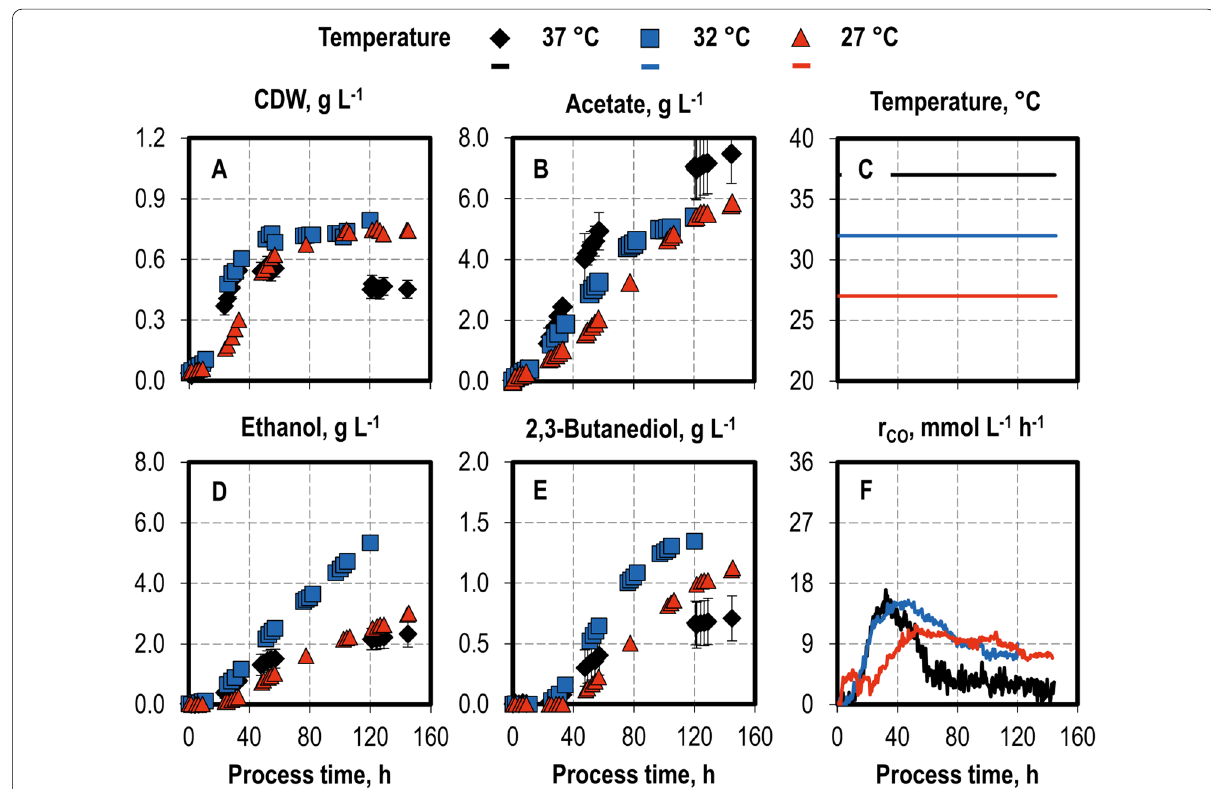
Fig. 2 Variation of temperatures in autotrophic batch processes with C. ragsdalei in a continuously gassed STR. Cell dry weight ( A CDW) and product concentrations ( B acetate; D ethanol; E 2,3‑butanediol) and the CO uptake rates ( F r CO ): 37 °C ( C black diamonds, black lines), 32 °C ( C blue squares, blue lines) and 27 °C ( C red triangles, red lines). The batch processes were operated at a working volume of 1 L, volumetric power input of 3.5 W L − 1 , pH 6.0, and a gas flow rate of 5 NL h − 1 with an inlet partial pressure of 0.2 bar H 2 , 0.2 bar CO 2 , and 0.6 bar CO. Standard deviations are shown for the processes at pH 6.0, which were conducted in triplicate; CO uptake rates are shown without standard